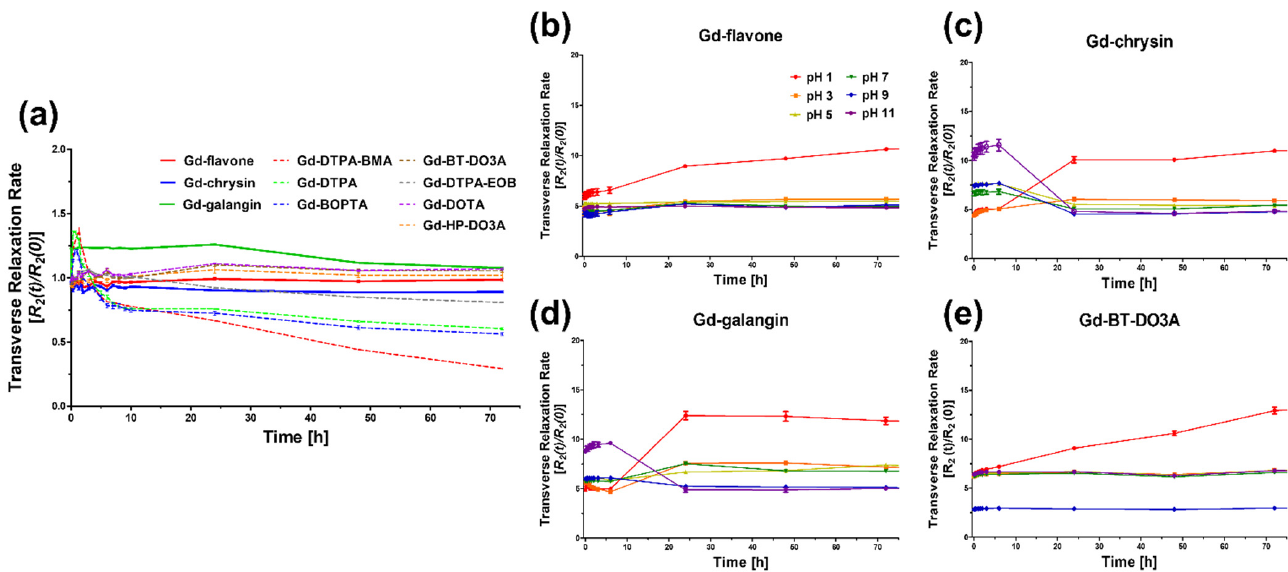
Figure 2. ( a ) Transmetalation kinetics stability of 1 mM Gd-flavone, Gd-chrysin, Gd-galangin and commercial MR contrast agents by transverse relaxation rate ( R 2 ) over time ( R 2 ( t )/ R 2 (0)) as a function of time at 3.0 T for 72 h. ( b – e ) pH stability of Gd-flavone, Gd-chrysin, Gd-galangin and Gd-BT-DO3A. Samples prepared at the same concentration with various pH buffers were measured at 3.0 T. An additional pH stability test is shown as Figure S34.